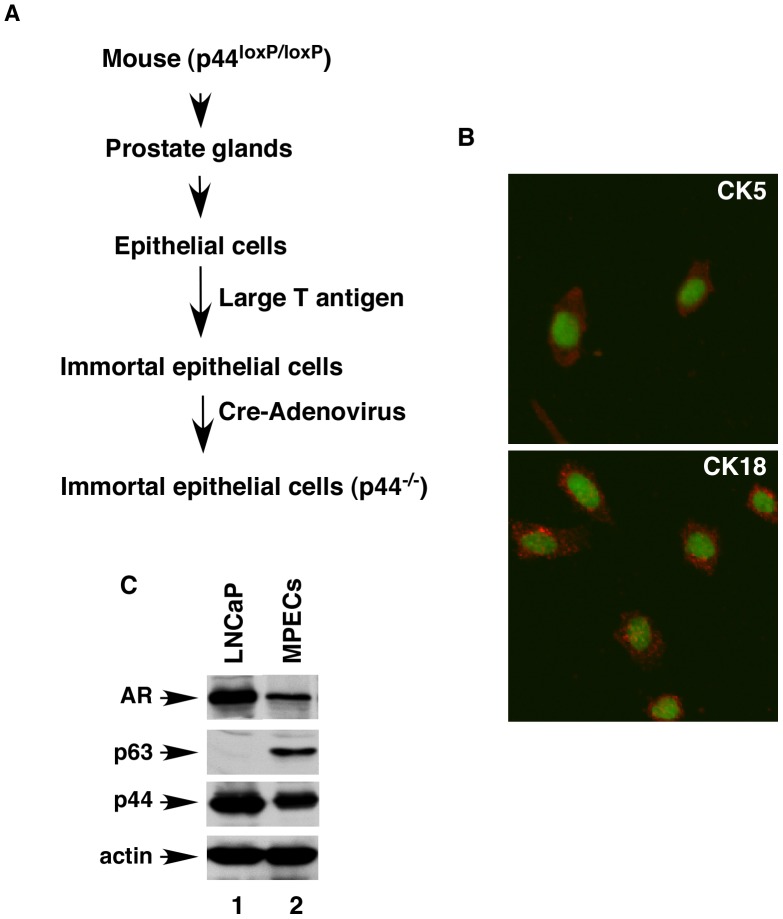
The Cre-mediated deletion of the p44 gene in prostate epithelial cells.(A) A diagram illustrating the procedure to generate p44-null (p44−/−) epithelial cells from the mouse whole prostate. (B) Epithelial cells were stained for CK5 and CK18 as indicated. The nucleus was stained with Sytox green. (C) Western blot analysis of whole cell lysates (10 µg) made from LNCaP (lane 1) or prostate epithelial (lane 2) cells analyzed with anti- AR, -p63, -p44, or -actin antibody as indicated.